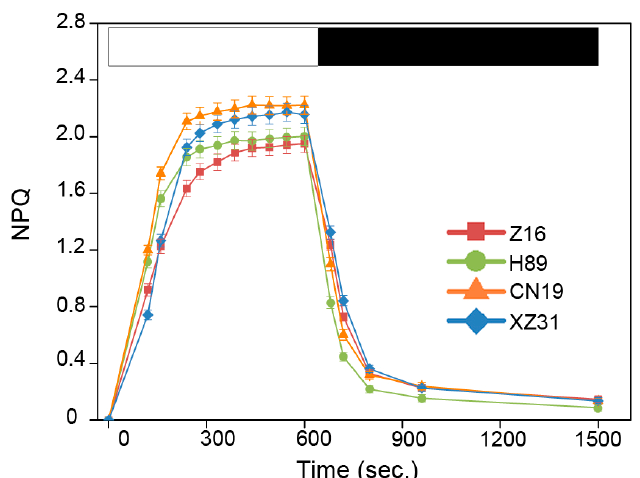
Figure 4. Non-photochemical quenching (NPQ) kinetics of Z16, H89, CN19, and XZ31 seedlings illuminated with 1000 μ mol ∙ photons ∙ m − 2 ∙ s − 1 for 10 min with a 15 min period darkness, as indicated by the white and black bars. Data represent an average of four independent measurements and are expressed as mean ± SD. Z16, H89, CN19, and XZ31 present accessions of Triticum monococcum (W2n), Triticum dicoccum (W4n), Triticum aestivum (W6n), and octaploid Triticale (T8n), respectively.